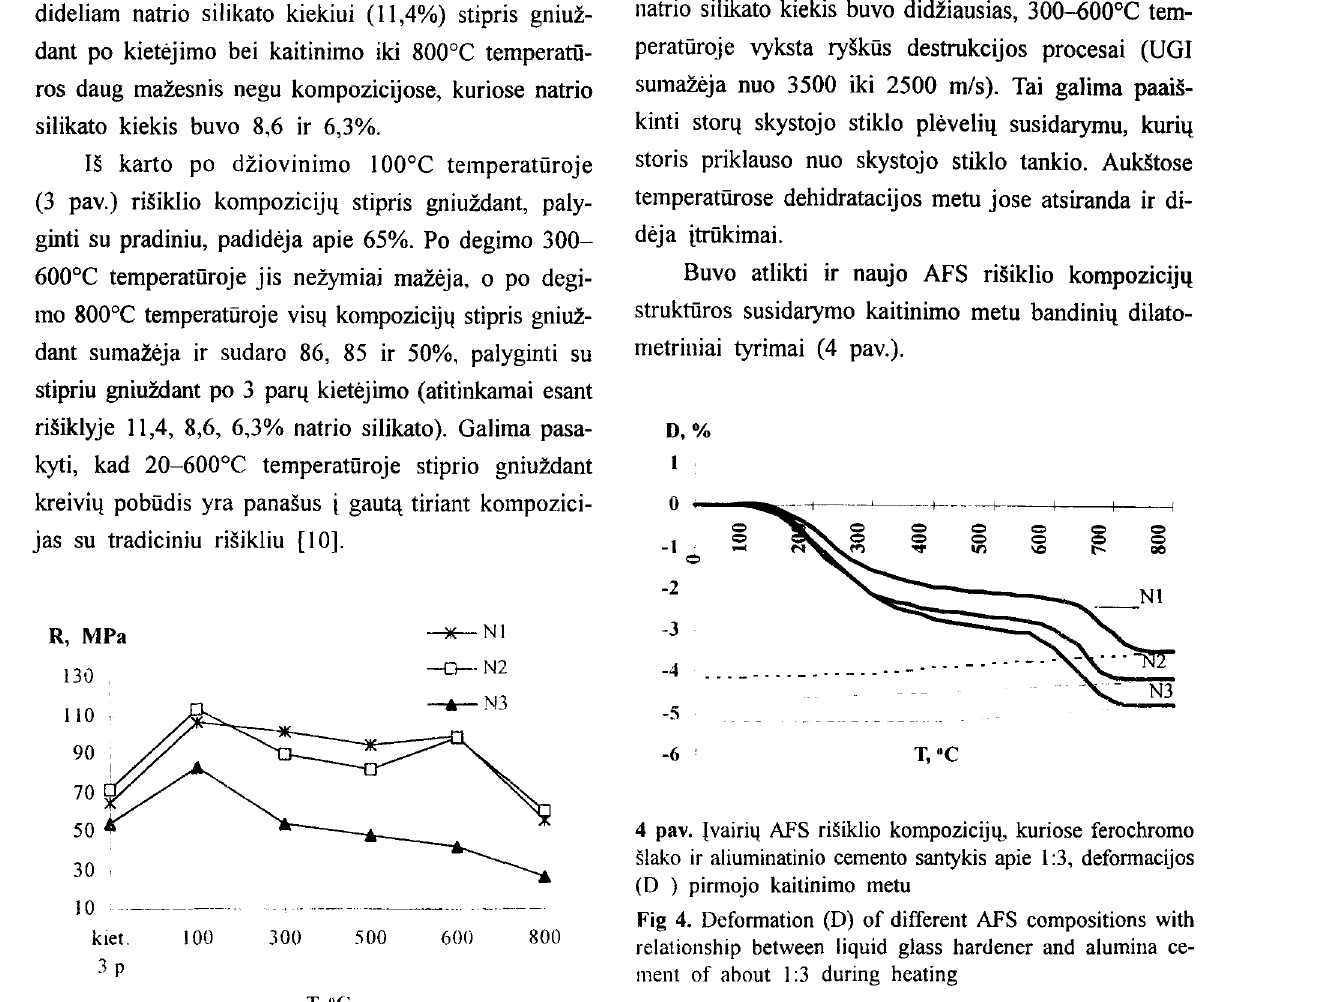
Fig 4. Deformation (D) of different AFS compositions with relationship between liquid glass hardener and alumina ce ment of about 1 :3 during